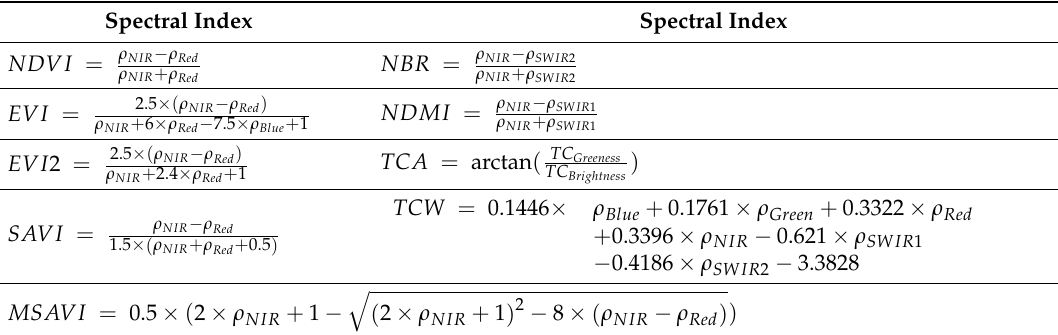
Formulas of nine Landsat-derived spectral